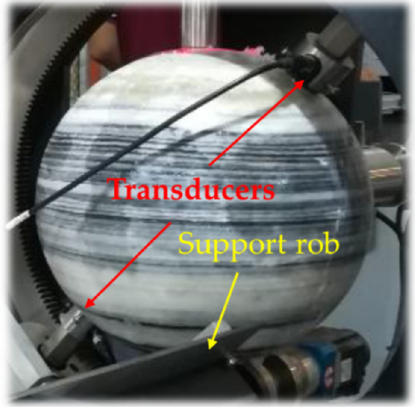
Figure 4. Granite rock sample from Jiaodong Peninsula, China.